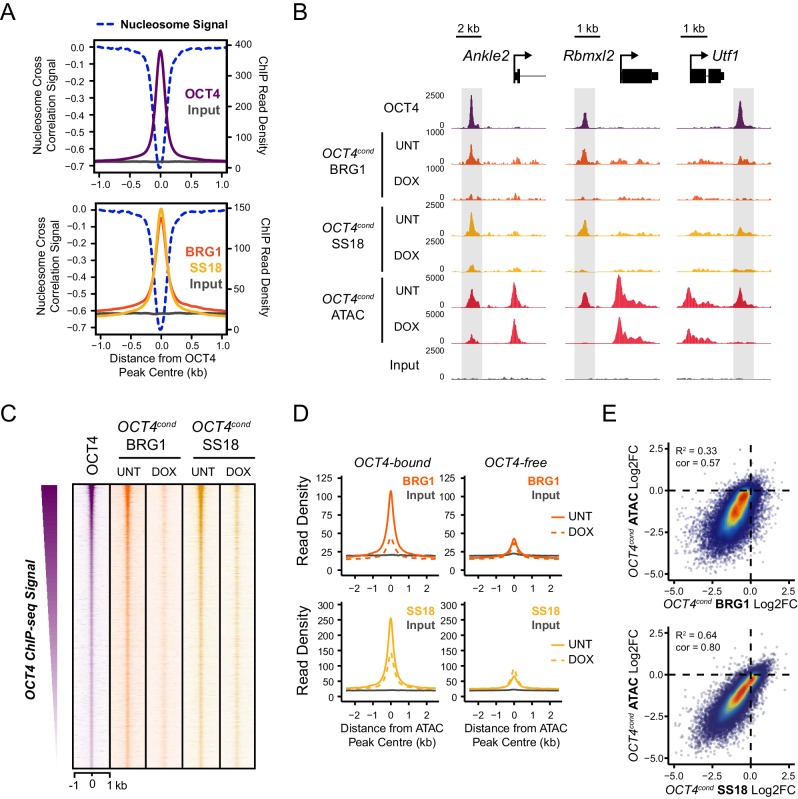
OCT4 is required for normal BRG1 chromatin occupancy at OCT4-bound regulatory elements.(A) A high resolution metaplot illustrating nucleosome occupancy, OCT4, BRG1 and BRG1-associated factor SS18 at OCT4 peaks (n = 15920; 10 bp windows) demonstrates that OCT4 and BRG1/BAF signal co-localises to the nucleosome-depleted region at OCT4 peaks. (B) Genomic snapshots of BRG1 and SS18 ChIP-seq in OCT4cond before (UNT) and after 24 hr doxycycline (DOX) treatment reveals loss of BRG1 and SS18 occupancy at distal OCT4 targets (highlighted in grey) following OCT4 removal. (C) A heatmap of OCT4 peaks (n = 15920) illustrating enrichment of BRG1 and SS18 at OCT4 target sites in wild type cells and subsequent loss of BRG1 following removal of OCT4. (D) A metaplot of BRG1 and SS18 ChIP-seq signal at ATAC hypersensitive sites with (OCT4-bound) or without (OCT4-free) OCT4 before and after deletion of OCT4. (E) A scatterplot comparing the changes in BRG1 and SS18 occupancy with the changes in chromatin accessibility (ATAC-seq) at OCT4 peaks after deletion of OCT4. R2 represents linear regression score, and cor reflects Pearson correlation coefficient.